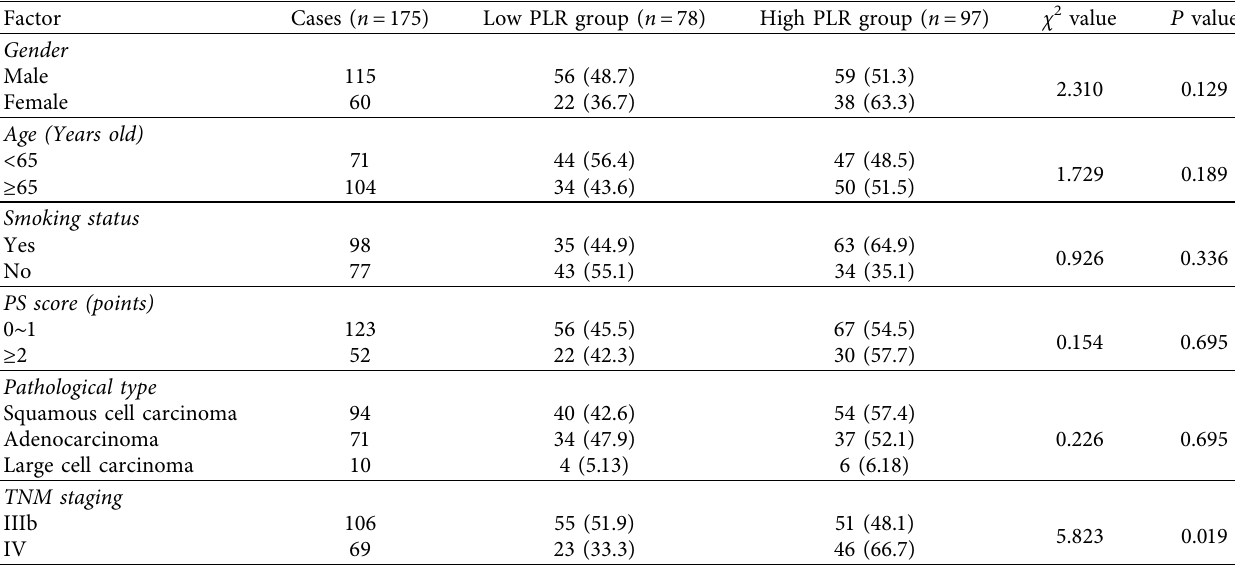
Table 1: Comparison of different clinicopathological features and PLR levels in patients with advanced NSCLC before chemotherapy ( n , %).